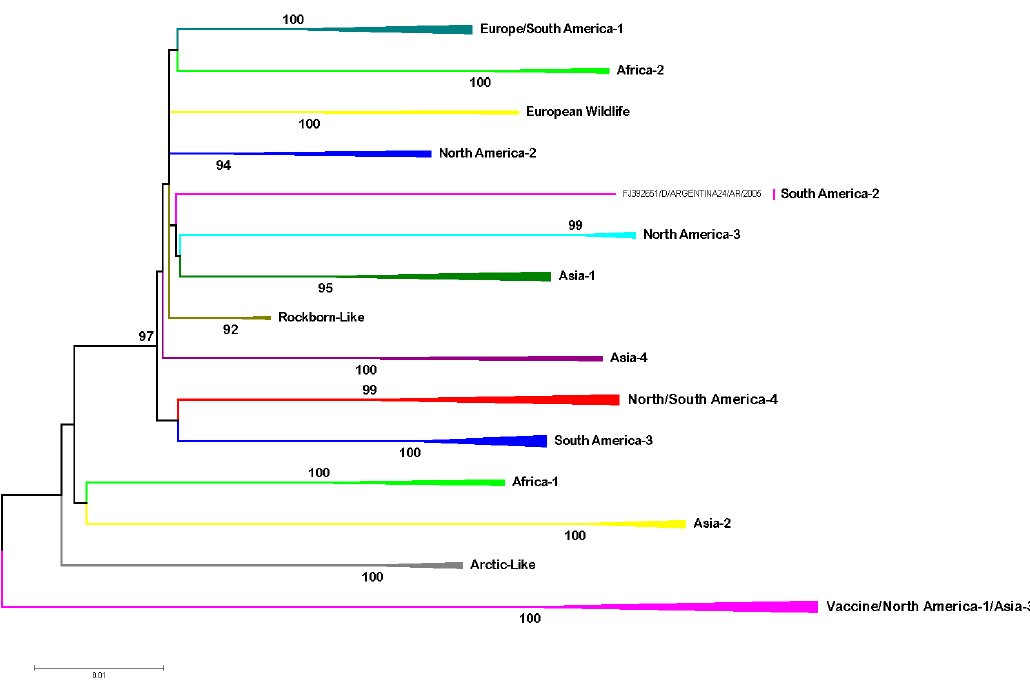
Figure 2. Phylogenetic relationship between 69 CDV strains based on the H gene sequence. The phylogenetic tree was obtained by the Maximum likelihood method with a Bootstrap of 1000 based on the evolution model T92 + G, 69 sequences were analyzed with a total of 1824 nucleotides. Evolutionary analyses were conducted in MEGA7.